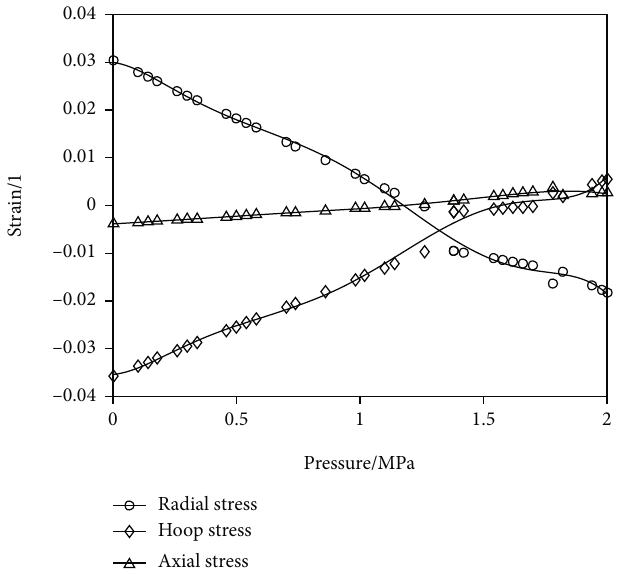
Figure 9: The trend of strain in three directions with pressure.